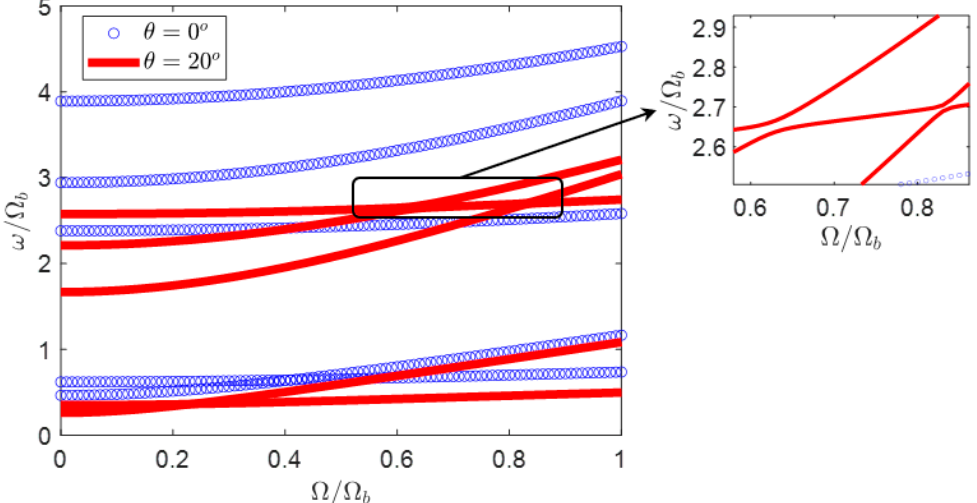
Figure 6. The effect of ply angle on the rotating frequencies of the composite beam with antisymmetric layup and for θ = 20 ◦ .